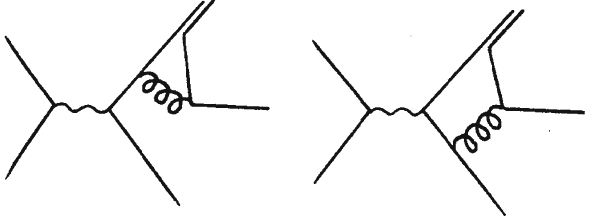
Fig. 1 Feynman diagrams used to calculate the c → ψ fragmentation